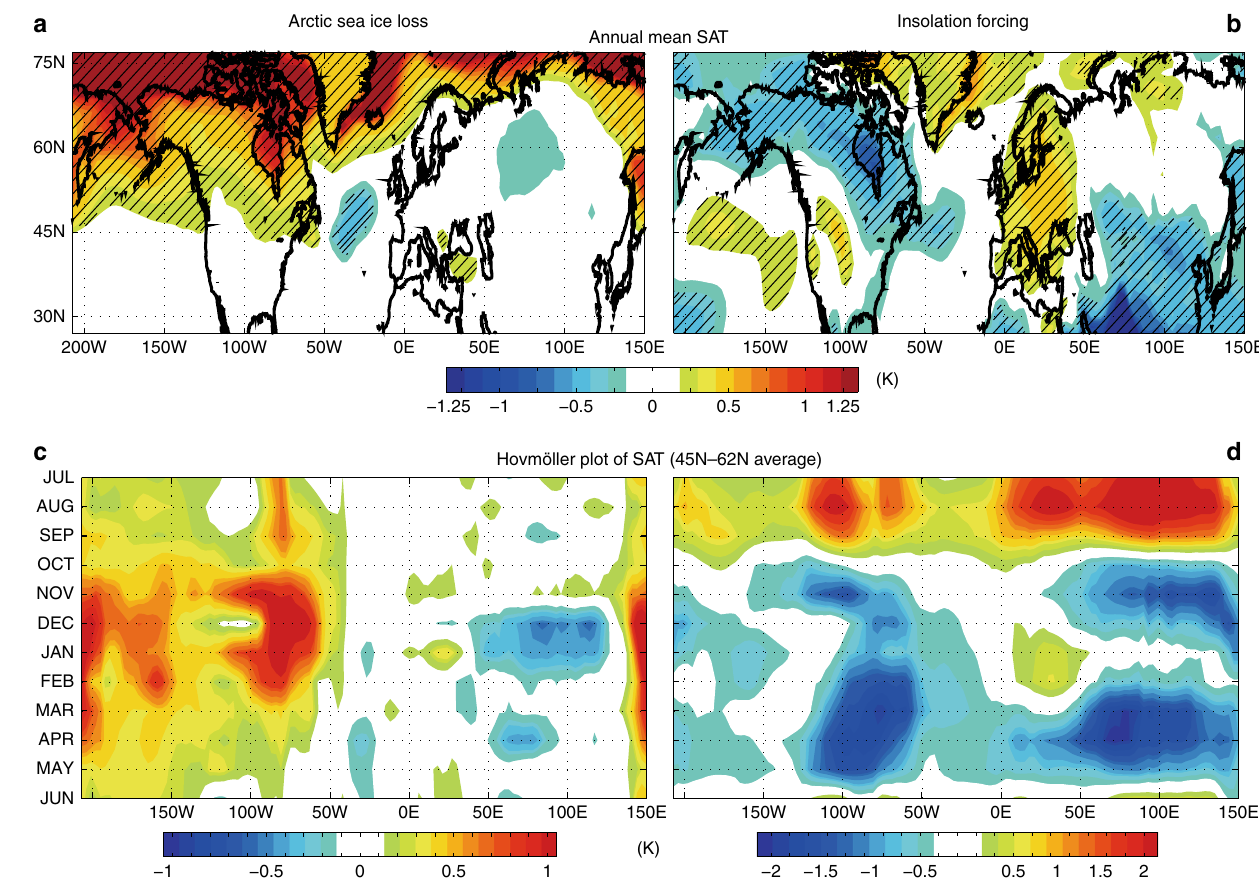
Fig. 2 Temperature responses to Arctic sea ice loss and insolation. Surface air temperature response to a , c Arctic sea ice loss and b , d insolation forcing. a , b The annual-mean surface air temperature anomalies (K) and c , d meridionally averaged (45° – 62°N), longitude – time Hovmöller plots of anomalous surface air temperature (K). The abscissa longitude and the ordinate is time (months). In a and b , statistically signi fi cant values ( p < 0.05) are